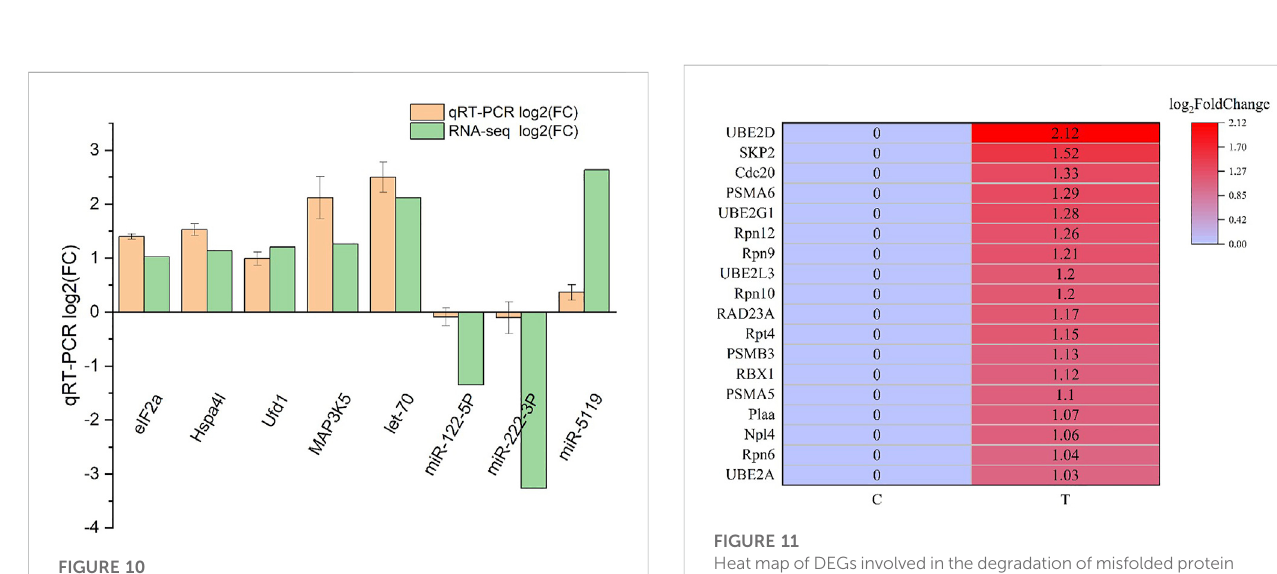
qRT-PCR validation of RNA-seq and miRNA-seq data. Negative values indicate the gene expression was down-regulated, while positive values indicate the gene expression was up-regulated.